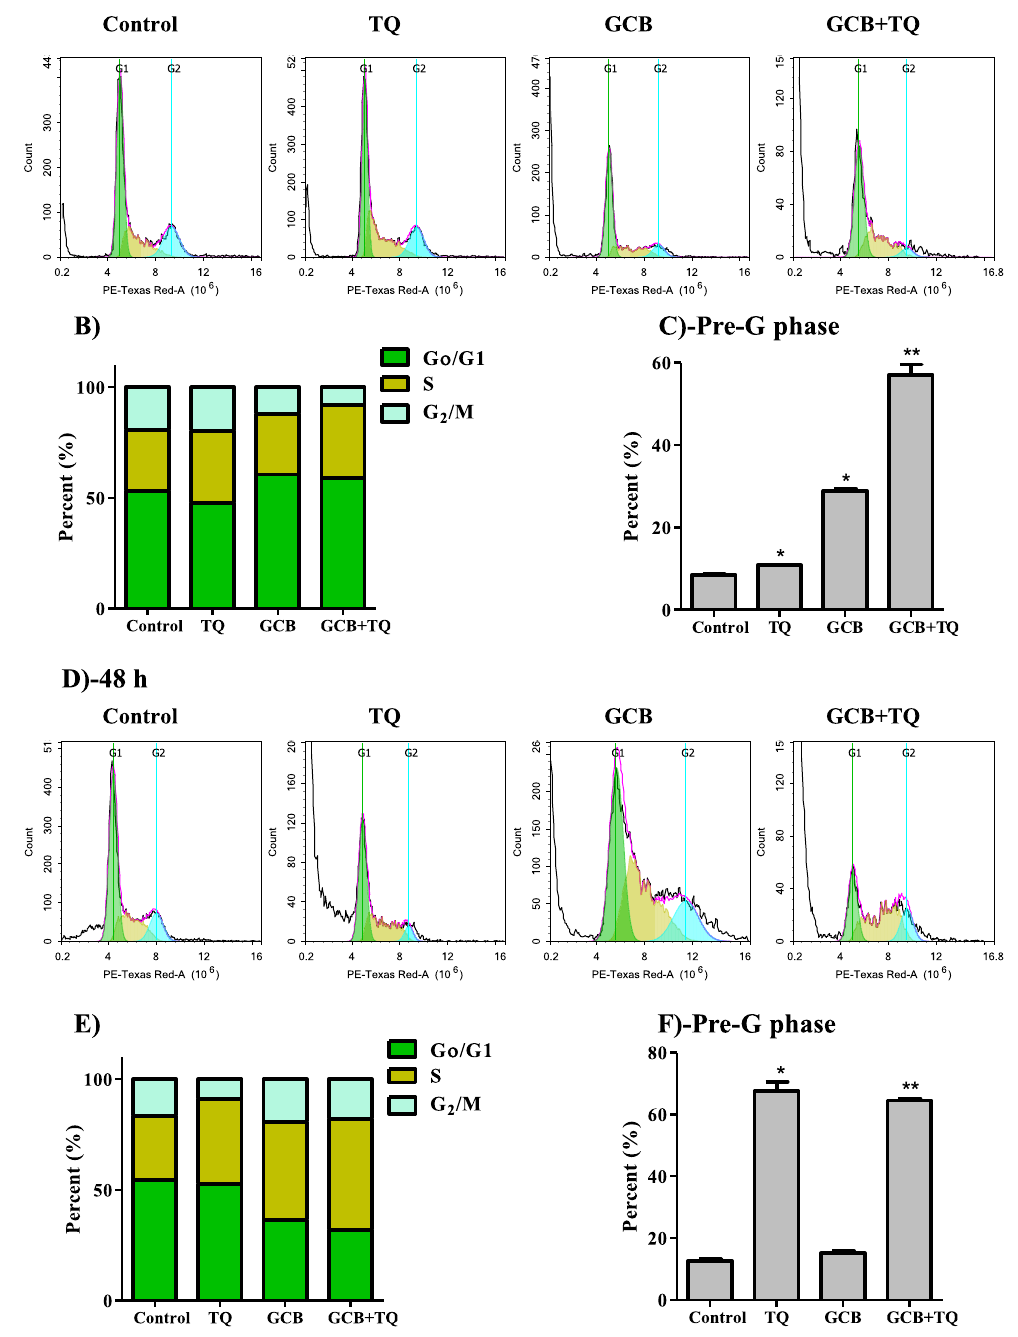
Figure 3. Effect of GCB, TQ and their combination on the cell cycle distribution of T47D cells. Cells were exposed to GCB, TQ or their combination for 24 h ( A – C ) or 48 h ( D – F ). Cell cycle distribution was determined using DNA cytometry analysis and different cell phases were plotted ( B , E ) as percentage of total events. Sub-G cell population was plotted as percent of total events ( C , F ). Data is presented as mean ± SD; n = 3. Data is presented as mean ± SD; n = 3. * Significantly different from control group. ** Significantly different from GCB